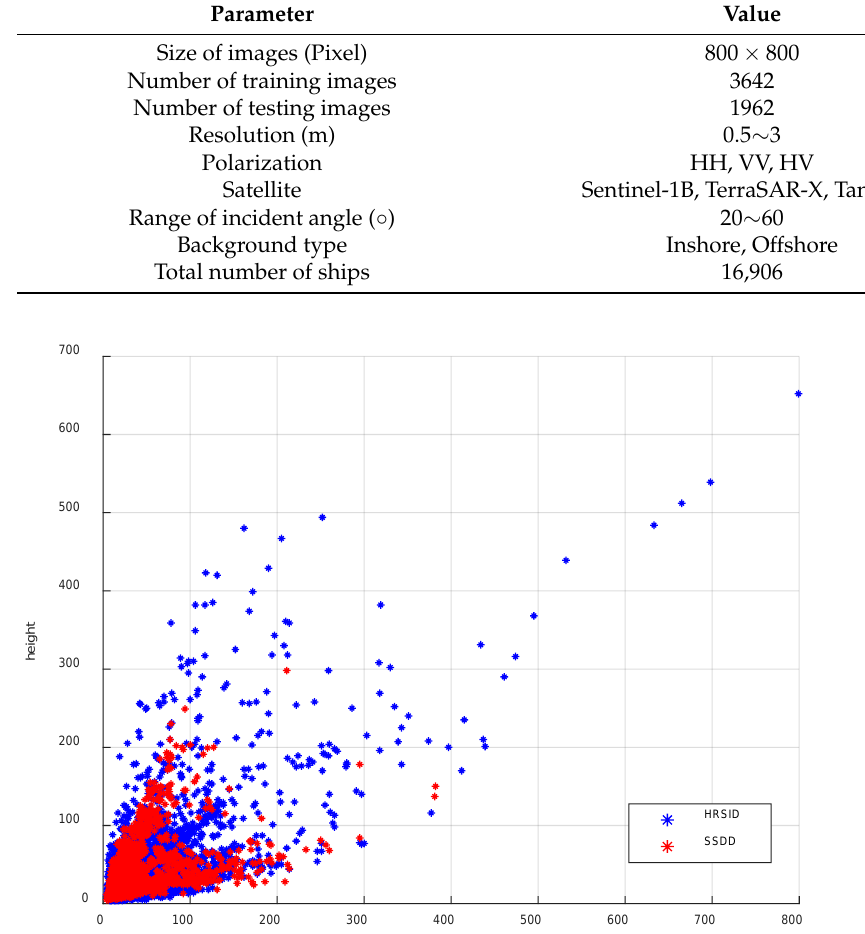
Figure 8. Distribution of bounding box length and width of HRSID and SSDD.